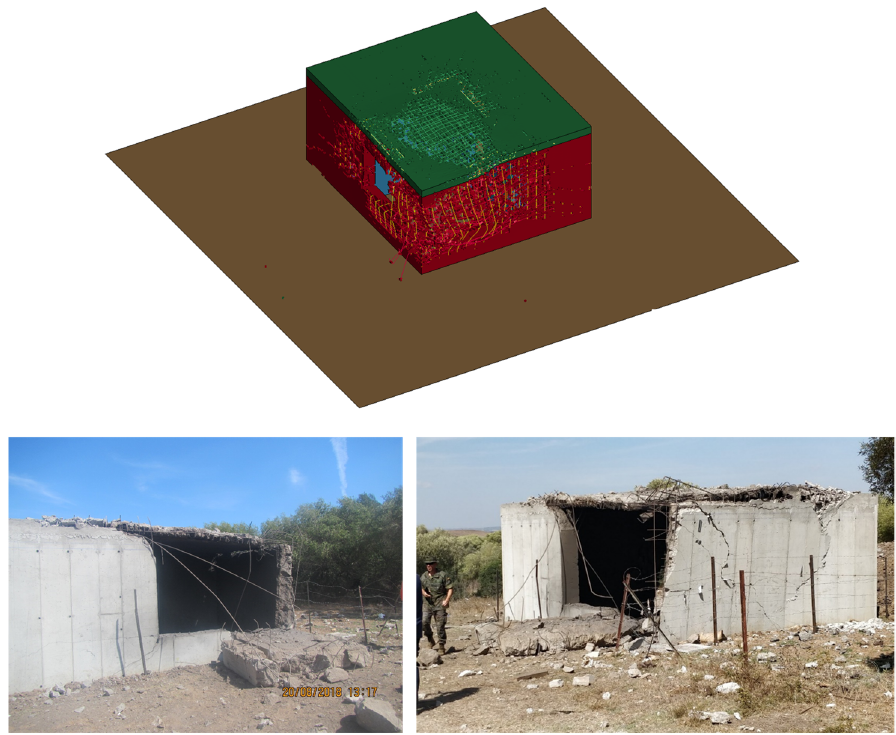
Figure 12. Final test (T8) results: numerical model and photographs.